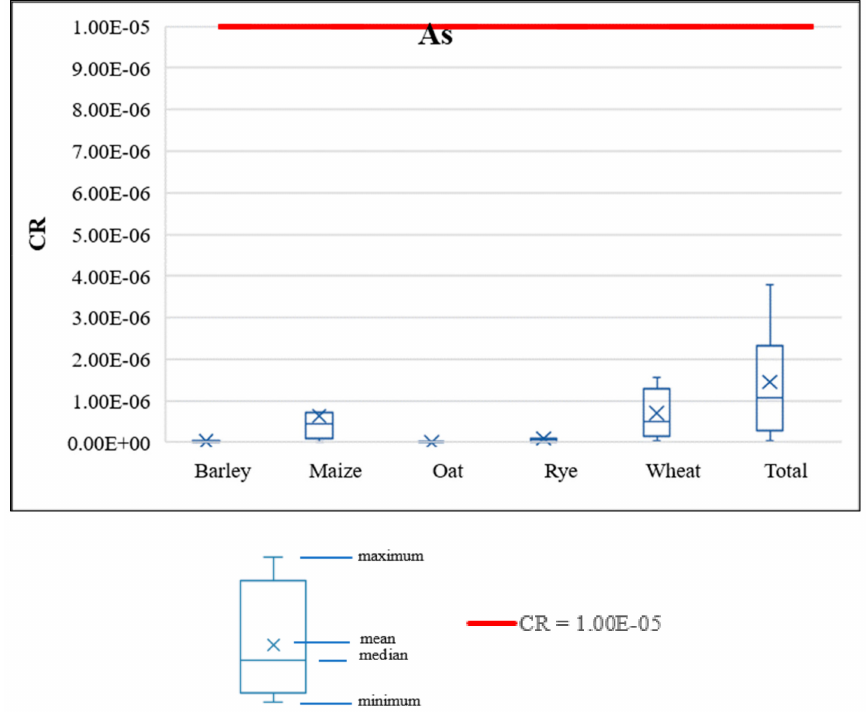
Figure 5. Carcinogenic risk (CR) values for As under the analyzed cereal intake